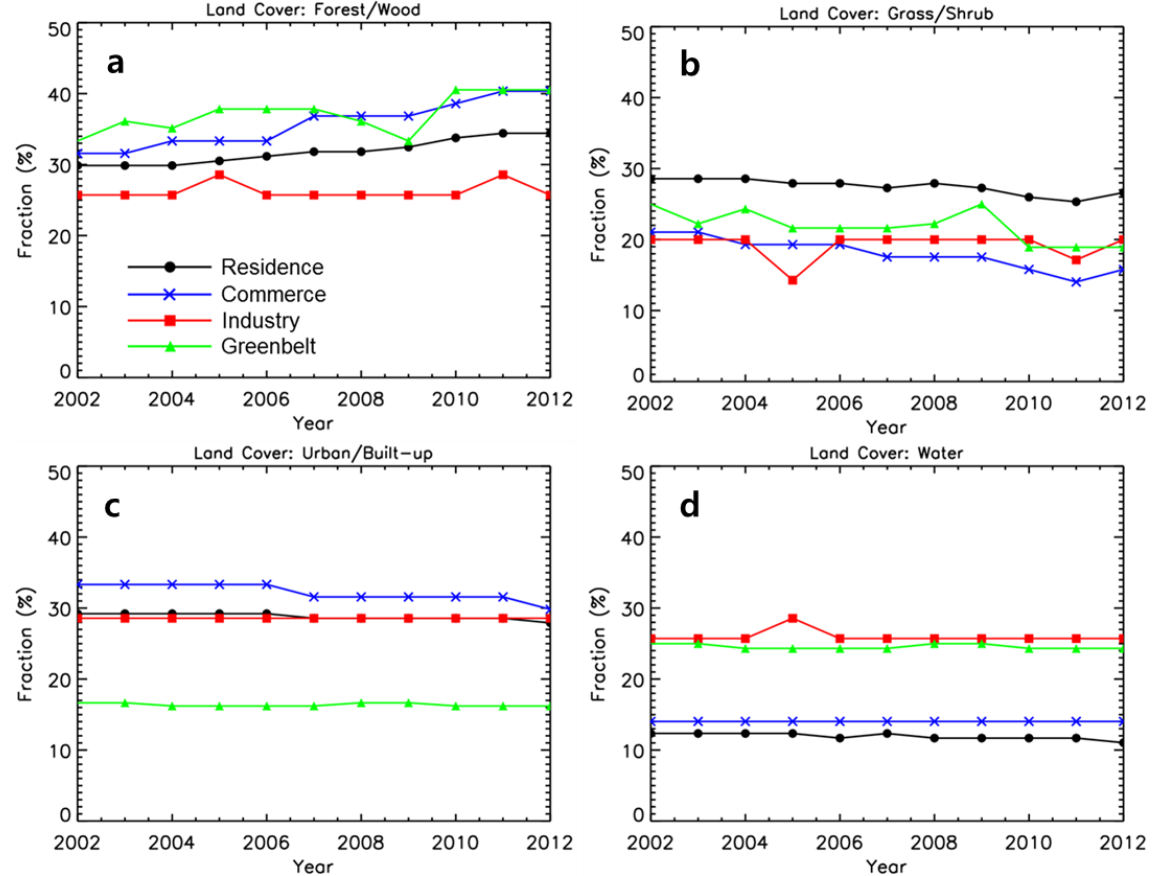
Figure 3. Interannual variations of the satellite-derived MODIS land-cover types (%) versus the MEK four land-use types (residence, com- merce, industry and greenbelt) of the 283 air pollution monitoring stations in South Korea during 2002–2012. In this study, for ease of comparison, the MODIS original types were regrouped into the following four covers: forest/wood, green/shrub, urban/built-up and water. Table 4. Comparison of the four land-use types of the MEK (residence, commerce, industry, and greenbelt) for 283 air pollution monitoring stations of the MEK during 2002–2012 with the satellite-derived land-cover types of the AVHRR and MODIS in a 0 . 25 ◦ × 0 . 25 ◦ grid. The AVHRR data were available for 13 land-cover types over the globe at a 1km × 1km pixel resolution during 1981–1994 (e.g., De Fries et al., 1998; Hansen et al., 2000). The MODIS data have been derived for 17 land-cover types over the globe at a 5km × 5km spatial resolution during 2002–2012 (e.g., Friedl et al., 2010). In this study, for comparison, the AVHRR and MODIS original types were regrouped into the following four land-cover types: forest/wood, grass/shrub, urban/built-up and water. In the table, the values with and without parentheses indicate the MODIS and AVHRR data,